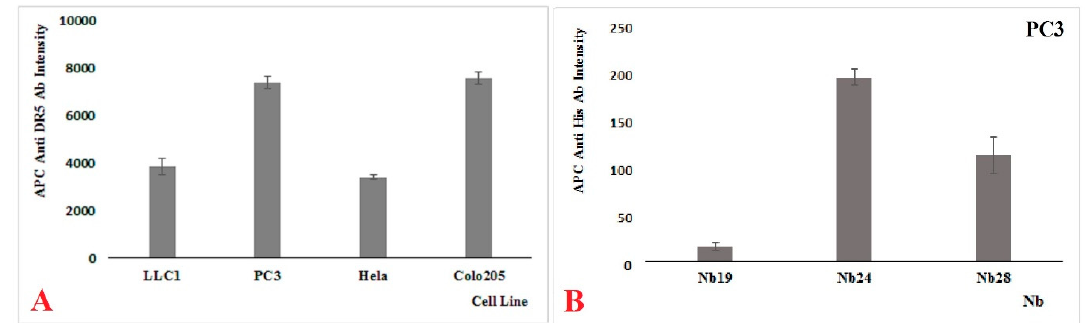
Figure 2. ( A ) Fluorescent activating cell sorting (FACS) data showing the expression of DR5 on various cell lines as probed with commercial DR5 specific antibodies. ( B ) Recognition of antigens on PC3 cell by DR5-specifc Nb24 and Nb28. Nb19 is specific for a bacterial adhesin and is used as negative control. The standard errors of the mean are obtained as the standard deviation divided by the root of the size of the sample ( n = 3)